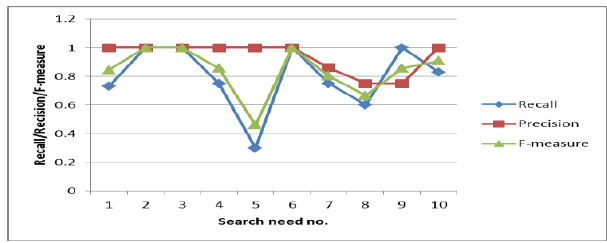
Fig. 16. Linear graph of precision, recall and F-measure for Law-Torch.